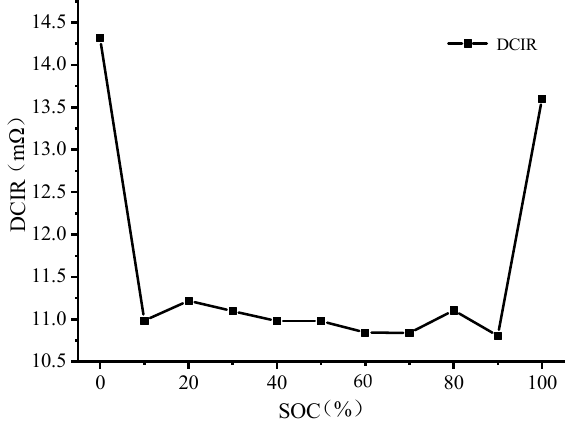
Figure 6. Changes in the DCIR with a full SOC.